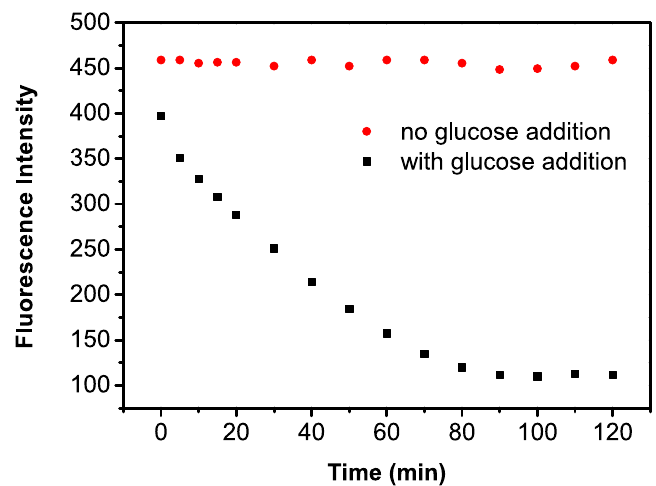
Figure 4. Effect of enzyme concentration on fluorescence intensity.